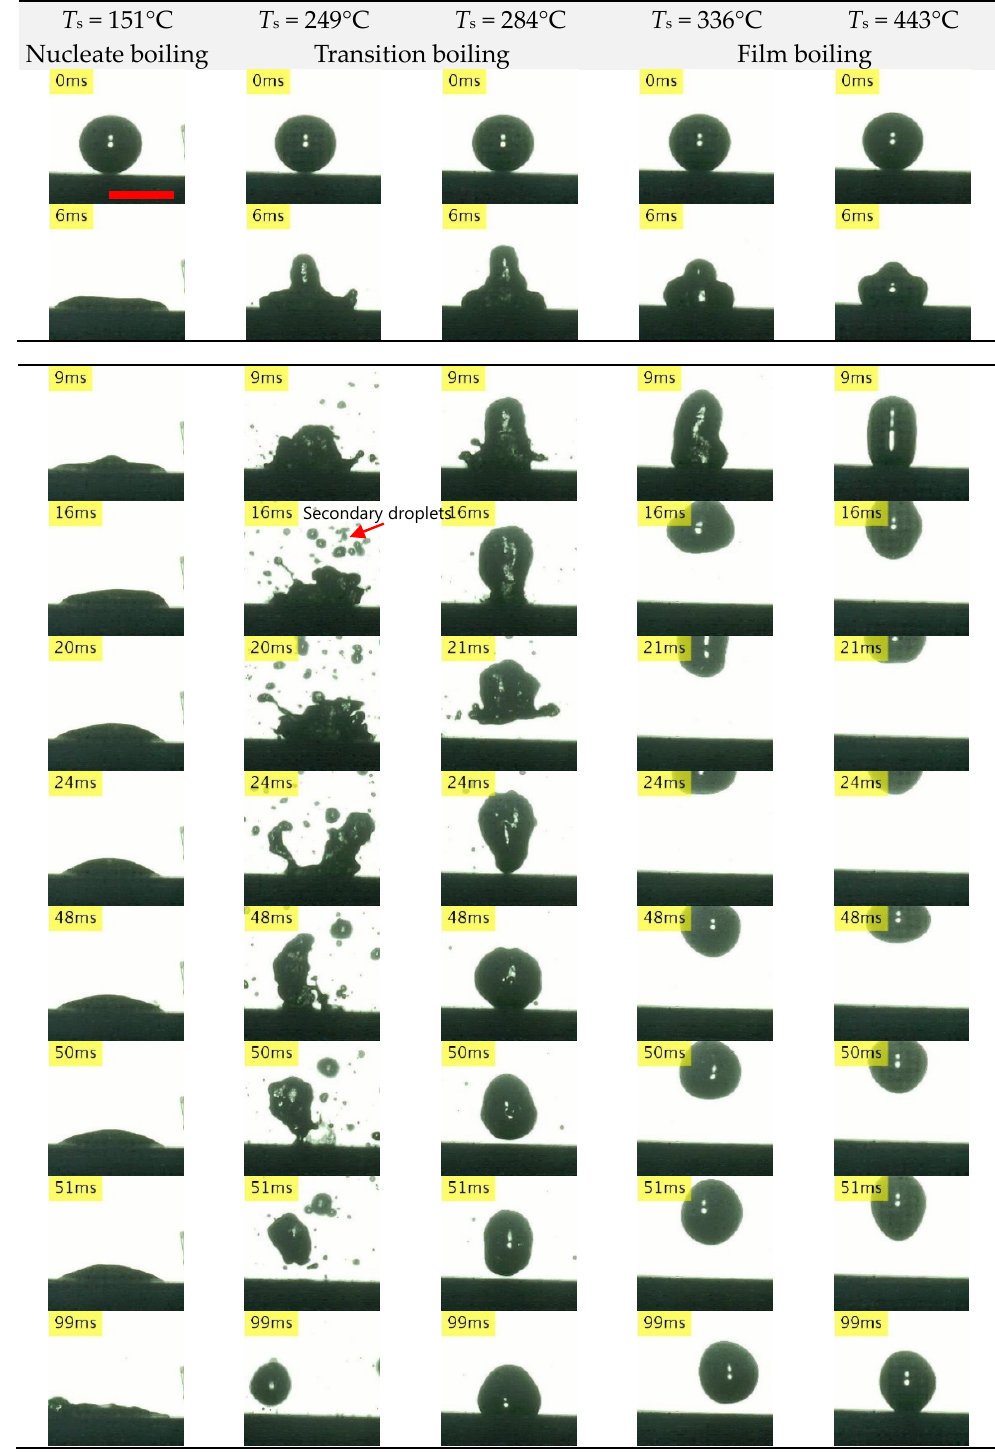
Figure 8. Sequential images of drop impact on flat surface. Scale bar is 2 mm.